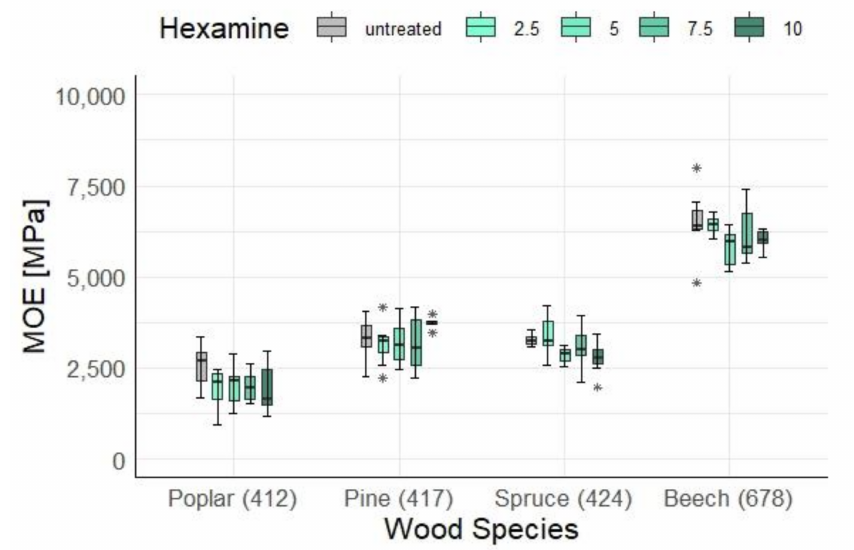
Figure 5. Boxplot chart of modulus of elasticity for different wood species at various hexamine amounts. The symbol “ * ” indicates the outliers of the tests performed.